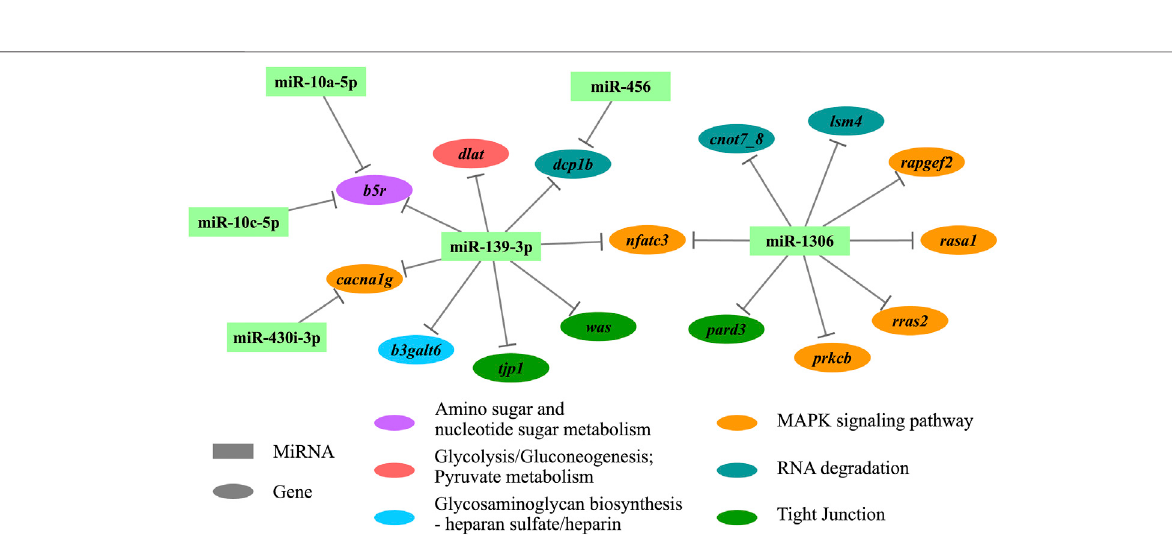
Frontiers in Genetics |